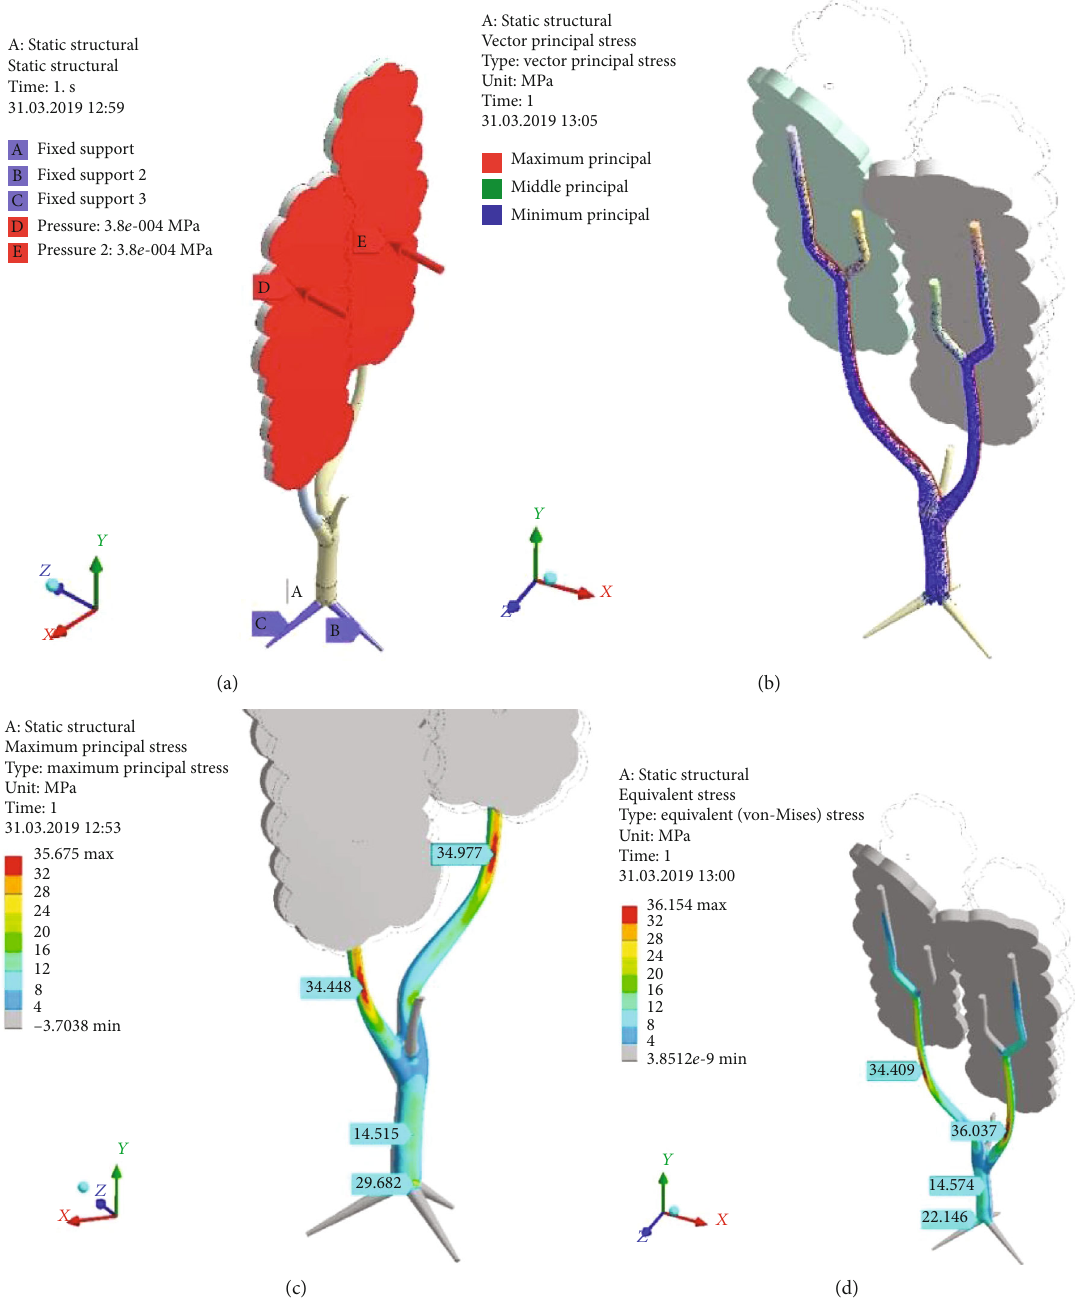
Þ = 380 Pa: (a) norm